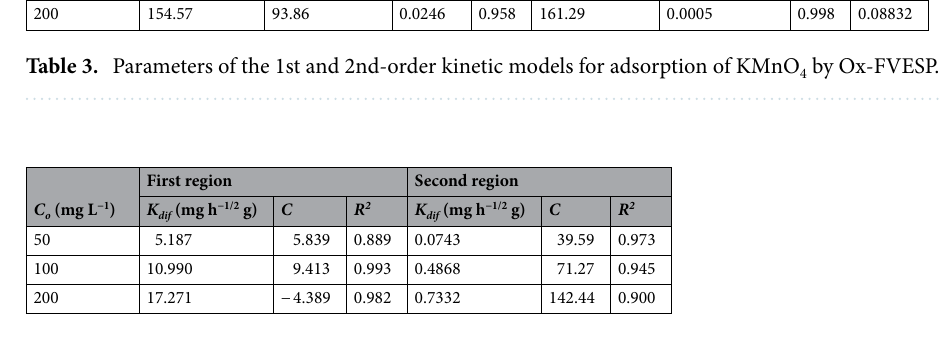
Table 4. Parameters of the intra-particle-diffusion kinetic model for KMnO 4 adsorption by Ox-FVESP.